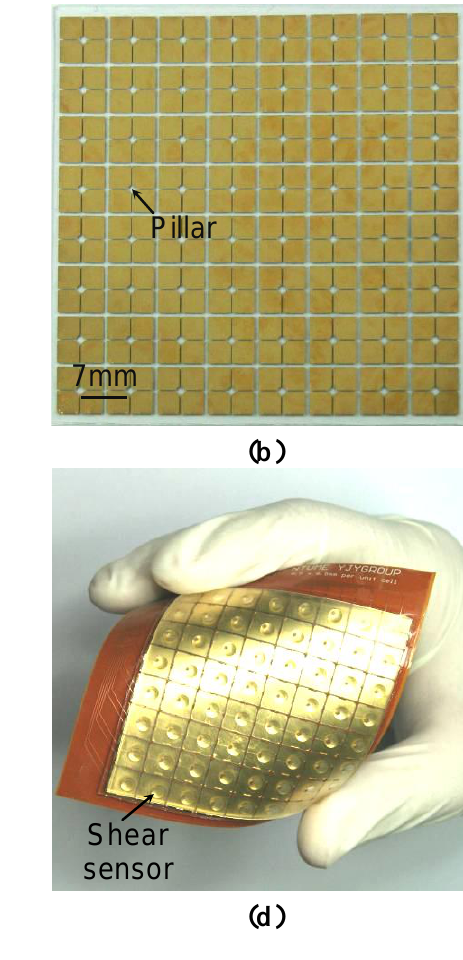
(c) The FPCB layer. (d) The fabricated flexible 8 × 8 shear sensing